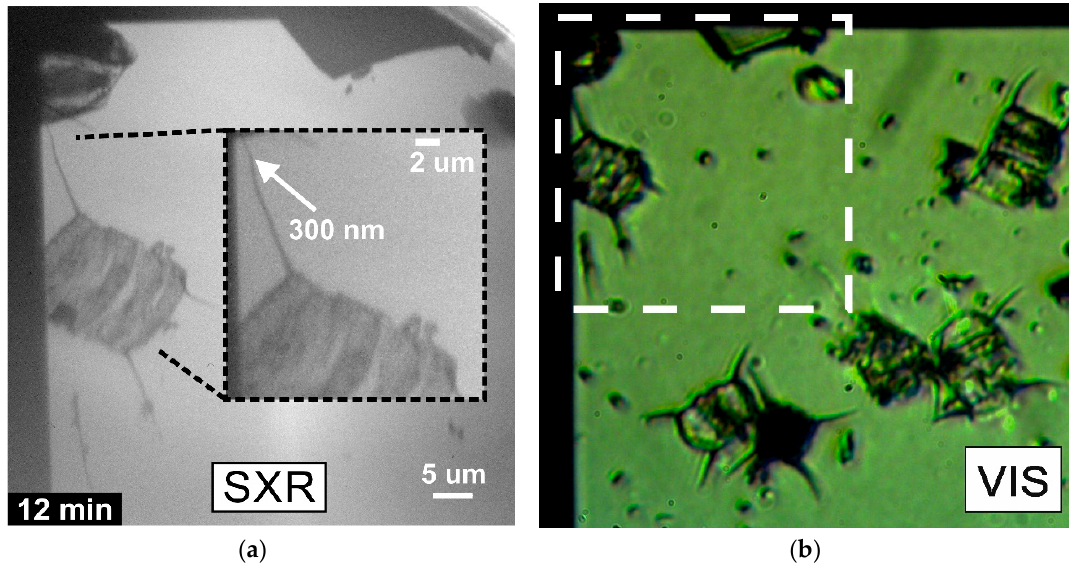
Figure 6. Comparison of the images of dried Desmodesmus communis deposited on a 50 nm thick Si 3 N 4 membrane. ( a ) A soft X-ray (SXR) image was acquired with 1400 SXR pulses (12 min). Scale bar is 5 µm. The black, dashed rectangle represents a zoomed area with a 2 µm scale bar. ( b ) The image was taken with a visible light microscope (VIS). The area marked by a white, dashed rectangle represents the field of view in image a .